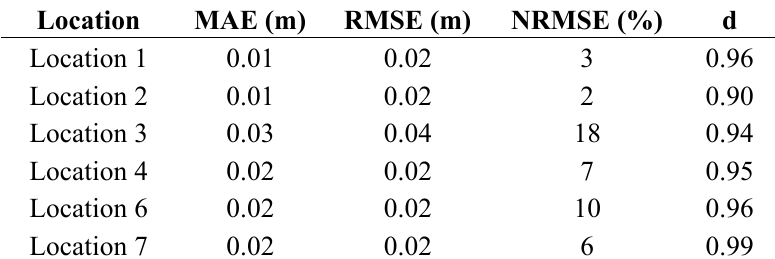
Table 1 . Mean absolute error MAE, root-mean-square error RMSE, normalized root-mean-square error NRMSE and index of agreement (d) for Run 1 (24 May 2010–14 June 2010). Location MAE (m) RMSE